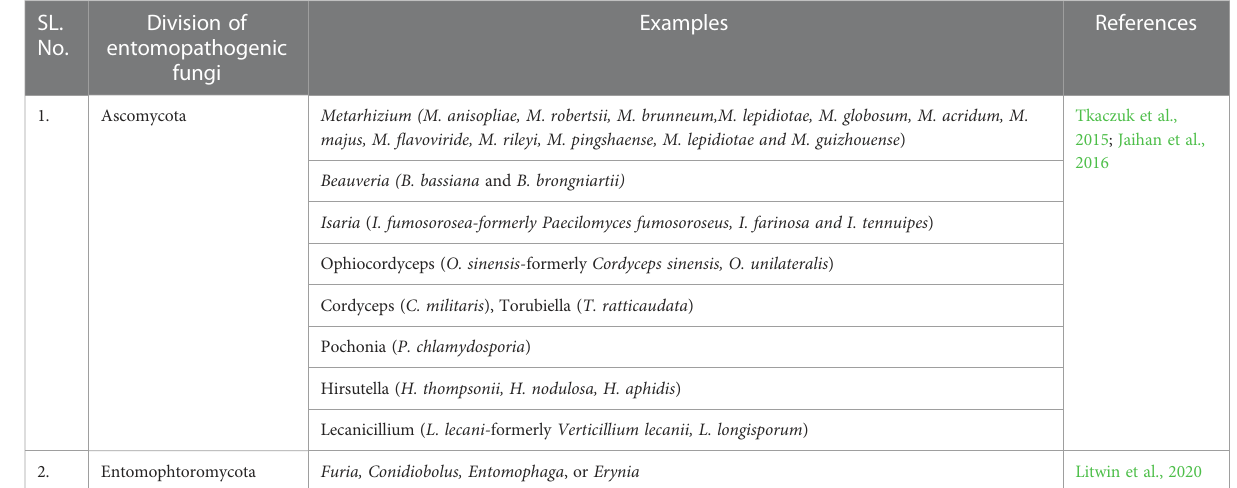
TABLE 1 List of Entomopathogenic Fungi (EPF).